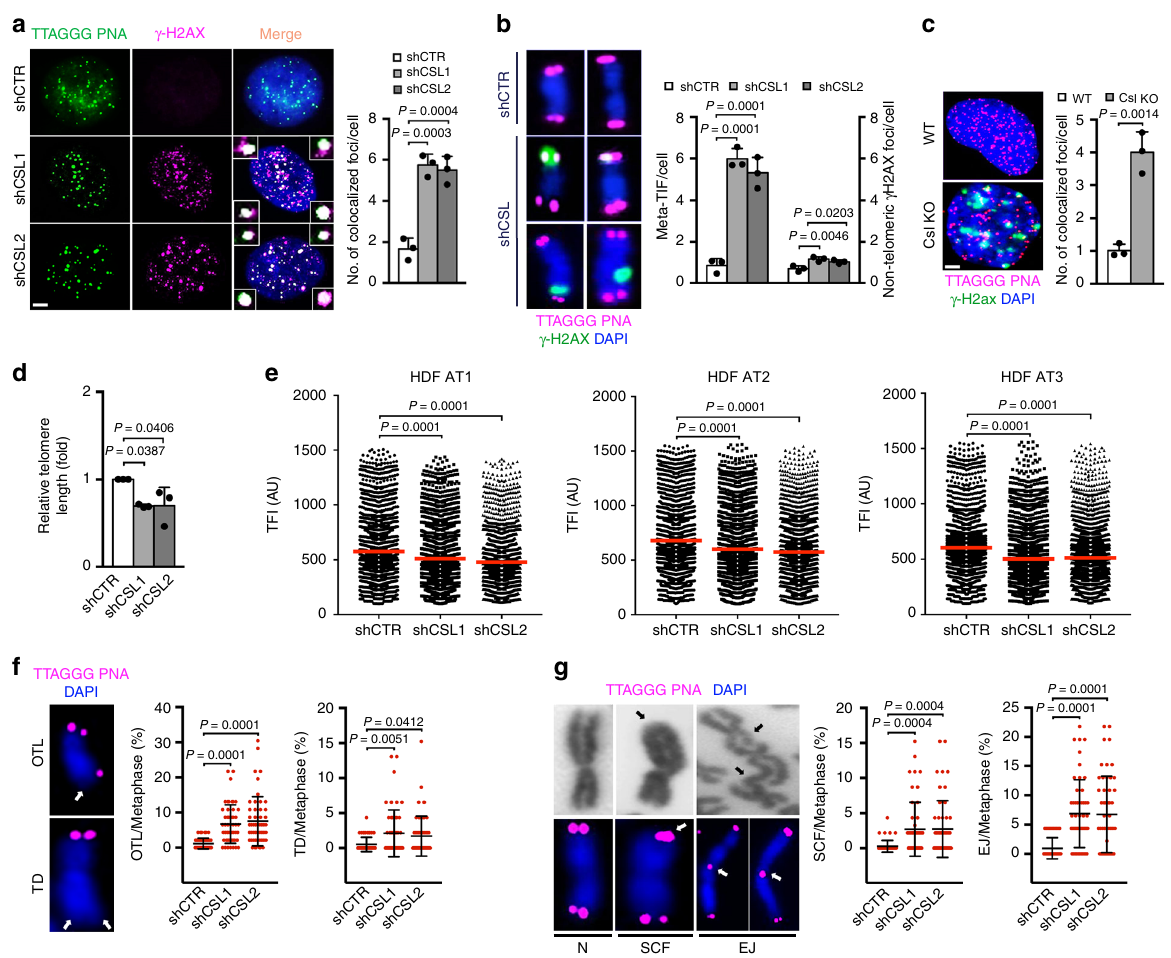
Fig. 3 CSL depletion triggers telomere loss and genomic instability in HDFs and MDFs. a Telomeric DNA Q-FISH (TTAGGG PNA, green) and γ -H2AX immunostaining (magenta) colocalization signals (foci) in HDFs plus/minus CSL silencing (5 days). Scale bar, 1 μ m. Fifty cells per sample were scored. n (strain) = 3, *** p < 0.001, one-way ANOVA. b Telomeric DNA Q-FISH (magenta) and γ -H2AX immunostaining (green) colocalization signals (telomere dysfunction-induced foci, meta-TIF) and nontelomeric γ -H2AX foci in metaphase chromosome spreads from HDFs plus/minus CSL silencing. Additional images are in Supplementary Fig. 2a. Forty spreads per sample were scored. n (strain) = 3, * p < 0.05, one-way ANOVA. c Telomeric DNA-FISH (magenta) and γ -H2ax immunostaining (green) colocalization signals (foci) in dermal fi broblasts from multiple mice plus/minus mesenchymal Csl deletion (WT/KO). Scale bar, 1 μ m. >25 cells per sample were scored. n (WT) = 3, n (KO) = 3, ** p < 0.01, two-tailed unpaired t -test. d qPCR analysis of average telomere length normalized to the ALBUMIN gene in HDFs plus/minus CSL silencing. n (strain) = 3, * p < 0.05, one-way ANOVA. e Analysis of telomere length by Q-FISH in HDFs plus/minus CSL silencing. Scatter plots show distribution of telomere fl uorescence intensity (TFI) in arbitrary units (AU). >3000 telomeres were quanti fi ed per sample. Histograms with telomere length distribution are in Supplementary Fig. 2b. n (telomere) > 3000, n (strain) = 3, **** p = 0.0001, one- way ANOVA. f Representative images of one telomere loss (OTL) and terminal deletion (TD) (white arrows) and quanti fi cation of the percentage of chromosomes carrying OTLs or TDs per metaphase in HDFs plus/minus CSL silencing. Additional images are in Supplementary Fig. 2c. Mean± SD, n (spread) = 50, n (strain) = 2, * p < 0.05, one-way ANOVA. g Representative phase contrast (top) and telomere FISH (bottom) images of normal chromosomes (N), chromosomes with sister chromatid fusion (SCF) or with chromosomal end joining (EJ) (arrows), and quanti fi cation of the percentage of chromosomes carrying SCFs or EJs per metaphase in HDFs plus/minus CSL silencing. Additional images are in Supplementary Fig. 2c. Mean± SD, n (spread) = 50, n (strain) = 2, *** p < 0.001, one-way ANOVA. Bars represent mean ±